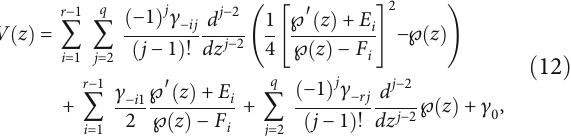
= 1/6 , 0 Figure 6: 3D graph of V = 1 , and α = 1 represent traveling wave solutions. z 1